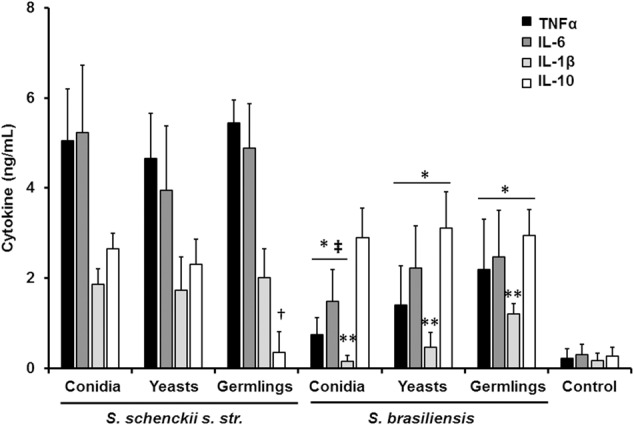
Sporothrix schenckii sensu stricto and S. brasiliensis are differentially recognized by human PBMCs. Human PBMCs were co-incubated 24 h with live conidia, yeast-like cells or germlings from either S. schenckii sensu stricto (s. str.) or S. brasiliensis, the supernatant collected and used to quantify the cytokine levels. ∗P < 0.05, when compared with the cytokine level stimulated by S. schenckii sensu stricto; †P < 0.05, when compared with other S. schenckii sensu stricto morphologies; ‡P < 0.05, when compared with S. brasiliensis germlings; ∗∗P < 0.05, when compared against other S. brasiliensis morphologies. Mock interactions of human PBMCs with culture medium were included as a control condition (control).